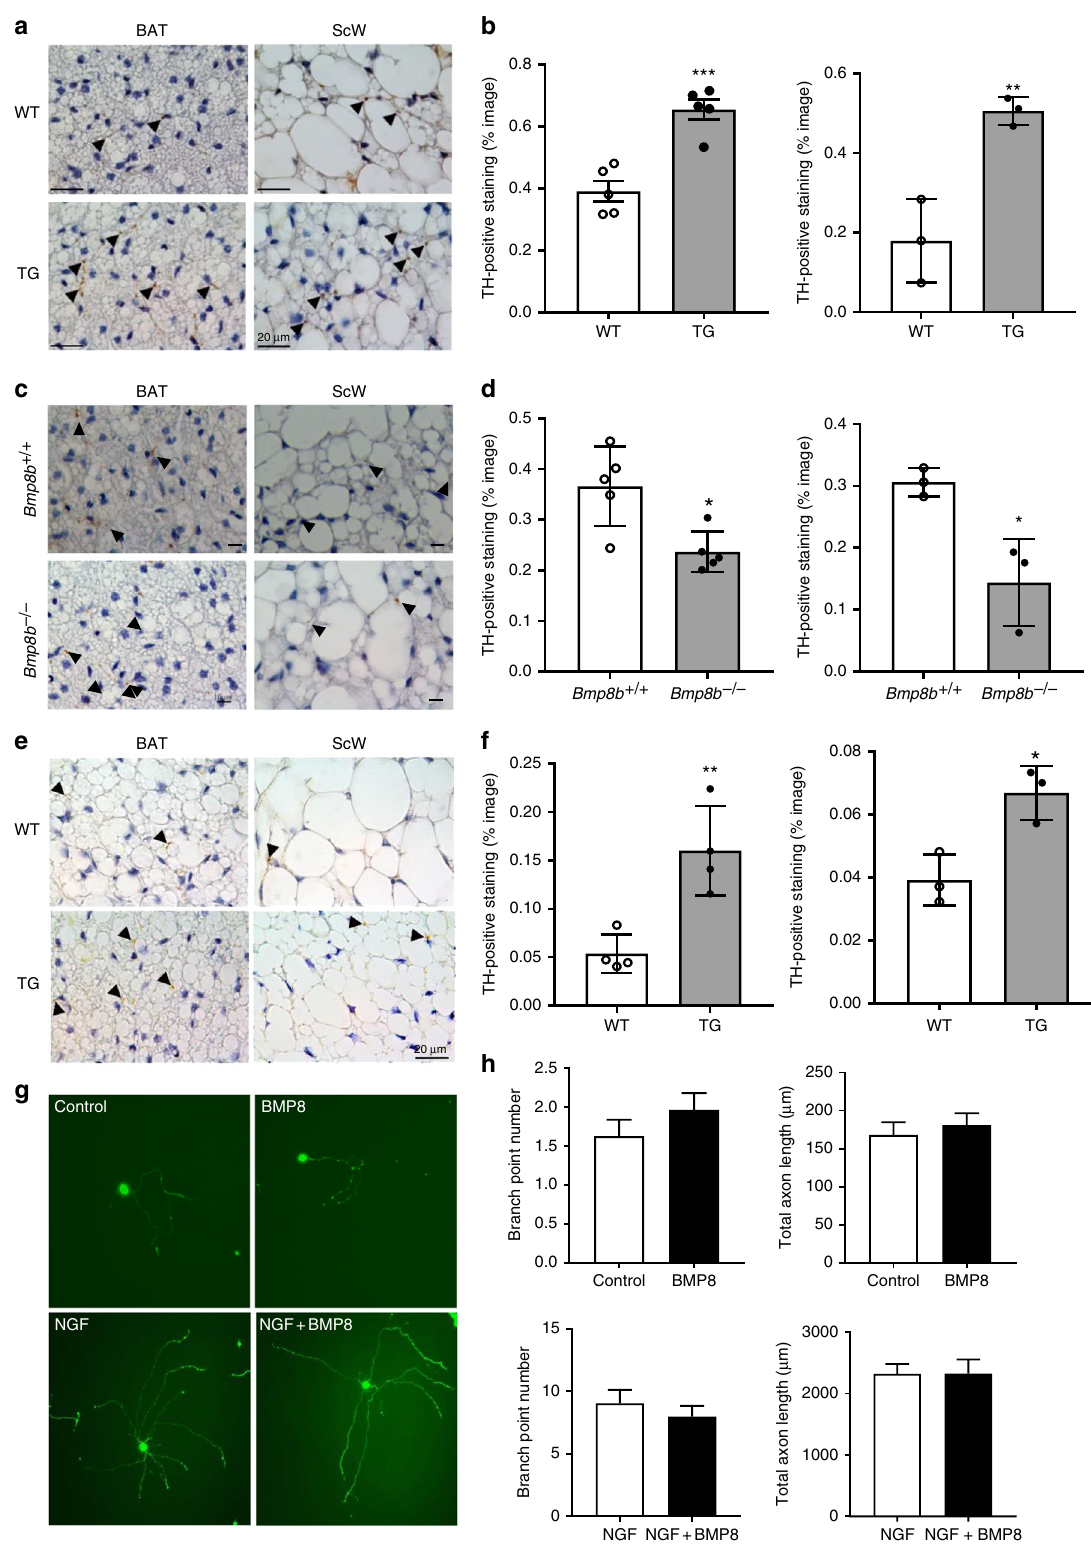
(Fig. 5d – h), were up-regulated in ScW of 4-week-old BMP8b TG mice and to a lesser extent in BAT (Supplementary Figure 5e-g). In support of a local regulatory effect, the ScW and BAT hyper- vascularization in Bmp8b TG mice was preserved when mice were born and housed at 28 °C (Fig. 5i, j).